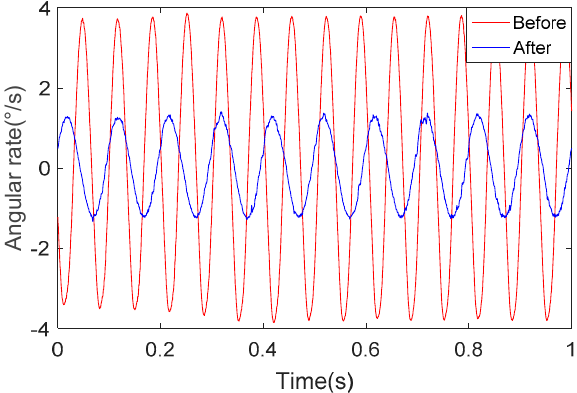
Figure 16. The angular rate of the pitch axis .